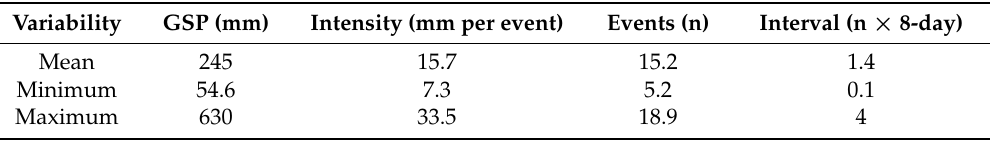
Table 2. Variability of growing season precipitation (GSP), intensity of precipitation events (Intensity), number of precipitation events (Events), the time interval between each set of consecutive events (Interval) of 2000–2016 on the northern Tibetan Plateau.